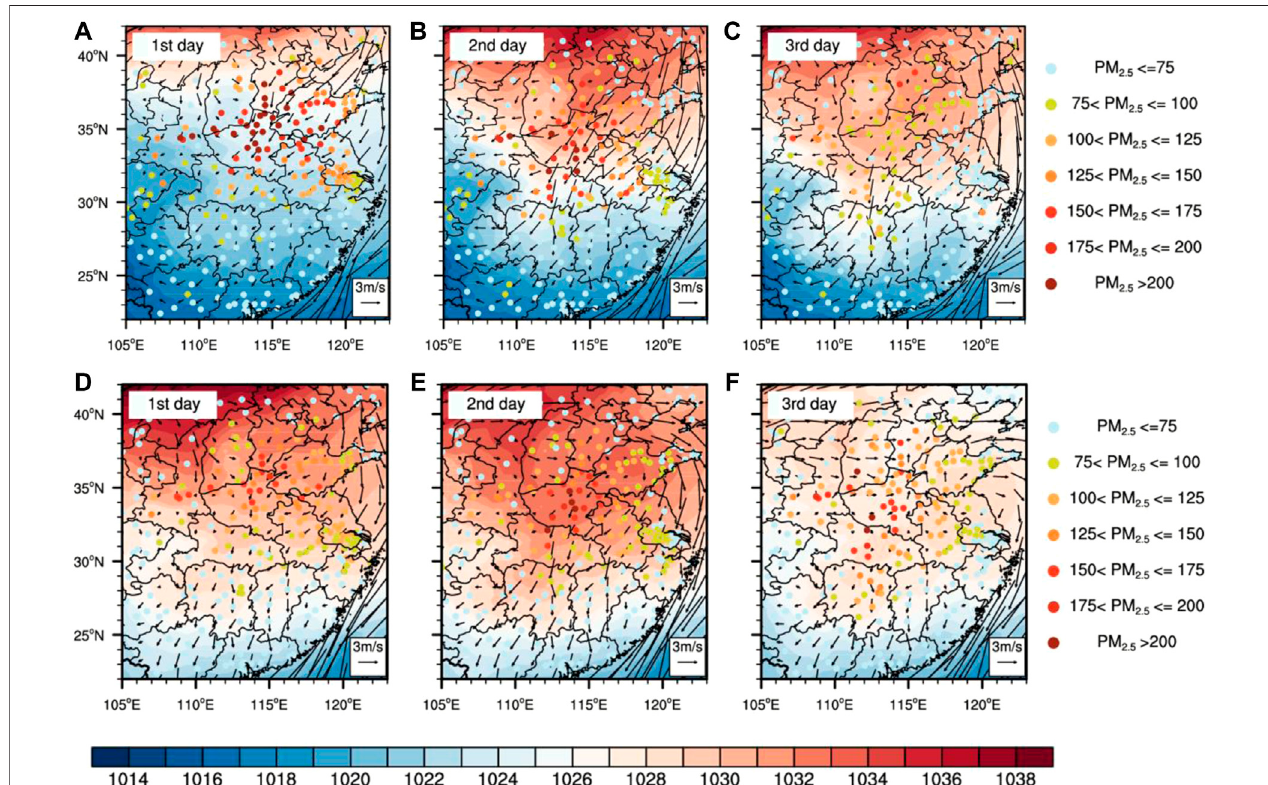
FIGURE 5 | Distributions of daily surface PM 2.5 concentrations ( μ g/m 3 ) observed at the sites (colored dots), daily sea-level air pressure (hPa, color contours), and daily 10 m horizontal wind vectors (arrow) of ERA5-Land during the heavy air pollution averaged over six severe PM 2.5 episodes of the top row (A,B,C) RTT and bottom row (D,E,F)